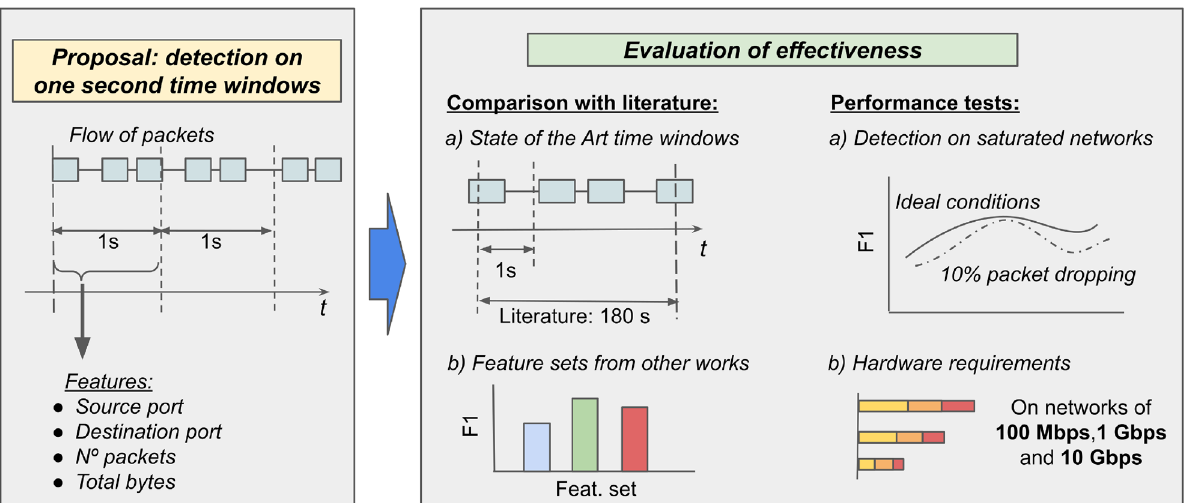
Figure 1. Visualization of the contributions presented in this work. We proposed an efficient classifier of network traffic capable of working on time windows of one second and yield the result in the following 1 to 2 seconds. Our model uses four features: the two port numbers (i.e., destination and source), the number of packets, and the number of bytes transmitted. First, we compared the F1 score of our model working on